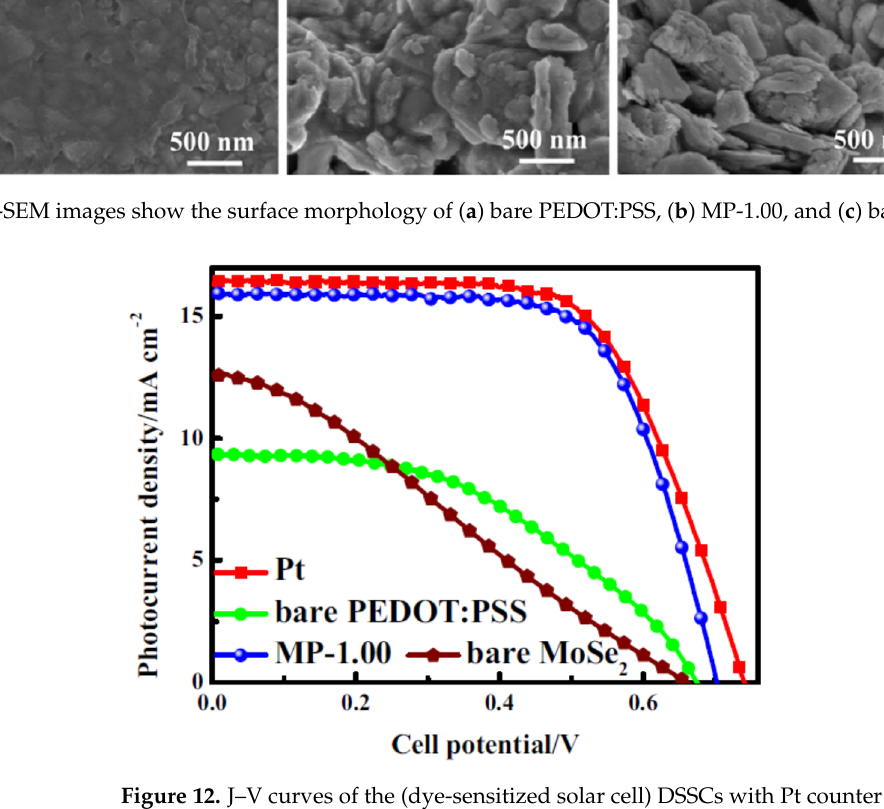
Figure 12. J–V curves of the (dye-sensitized solar cell) DSSCs with Pt counter electrodes (CEs), bare PEDOT:PSS CEs, MP-1.00 CEs, and bare MoSe 2 CEs [46]. Table 1. Photovoltaic parameters (η (%), V oc (V), j sc (mA cm −2 ), and fill-factor (FF)) of the DSSCs with various CEs were measured at 100 mW cm −2 (AM 1.5G). The standard deviation data for each kind of DSSC were obtained from three cells with the same fabrication processes [46] .